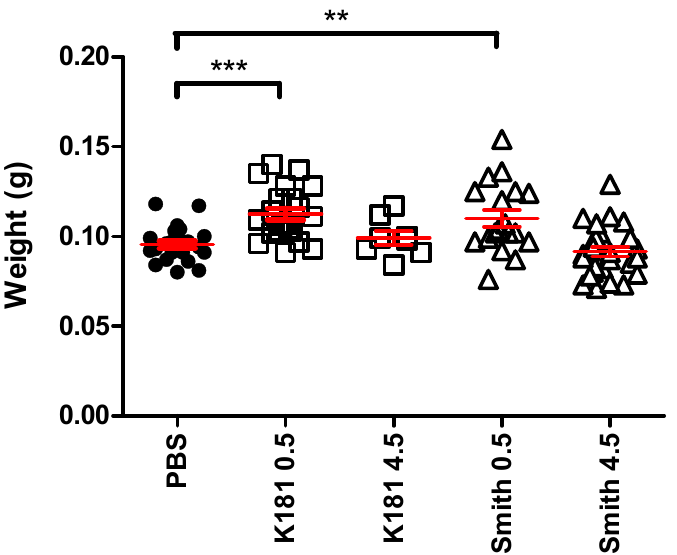
Figure 1. Effect of MCMV infection during pregnancy on placental weight (placental weights of E18.5 fetuses inoculated on day 0.5 or day 4.5 of pregnancy). Female BALB/c mice ( n = 5) were infected with 2 × 10 4 PFU MCMV (K181 Perth or Smith strain TCV) or the same volume of phosphate buffered saline (PBS) on the day of fertilization (E0.5) or on the day of blastocyst implantation (E4.5, viruses only) via the intraperitoneal route. Placentae were collected on E18.5 and weights were recorded. Mean ± SD are shown in red. ** p < 0.01. *** p < 0.001, ANOVA, Tukey’s multiple comparison test.